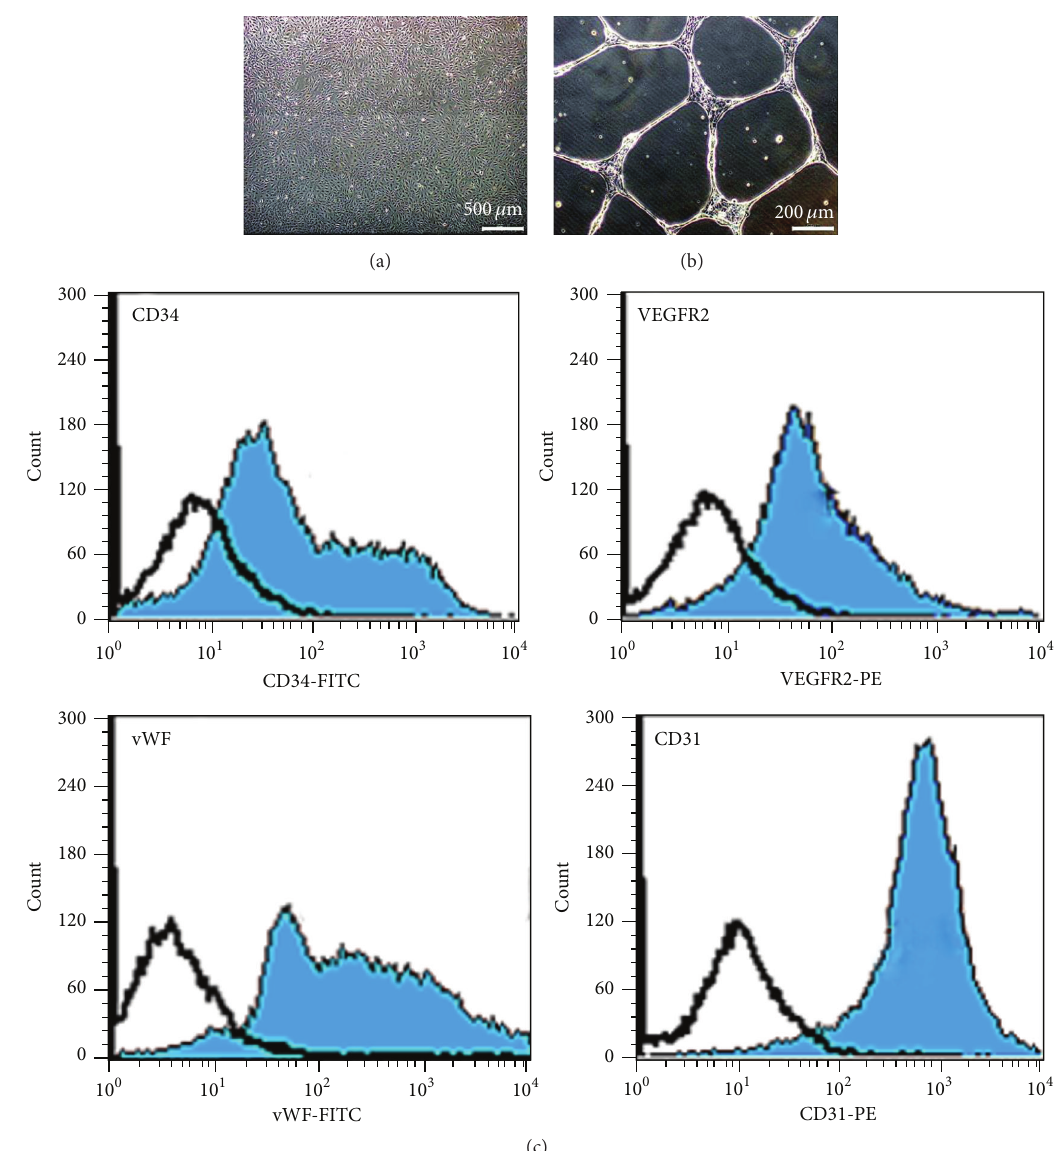
Figure 2: Characteristic of endothelial progenitor cells (EPCs). (a) Cobblestone-like morphology of EPC colony appeared after 7 days of culture (scale bar = 500 𝜇 m). (b) Capillary-like structures derived from EPCs after culture on Matrigel for 24 hours (scale bar = 200 𝜇 m). (c) Immunophenotype of EPCs as determined by flow